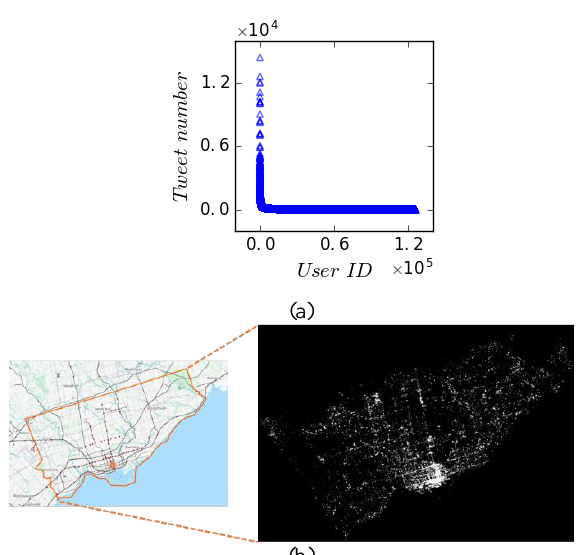
Figure 1. (a) Distribution of tweet volume posted by each user; and (b) mapped tweets (the lighter the more tweets posted)